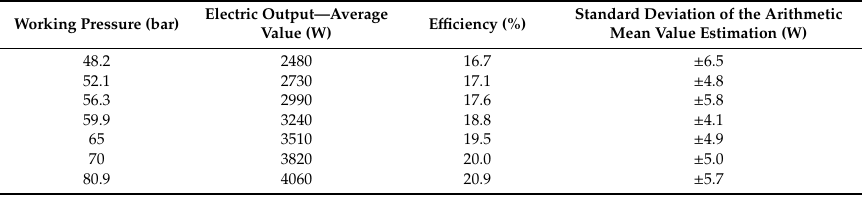
Table 2. Measured electric output with standard